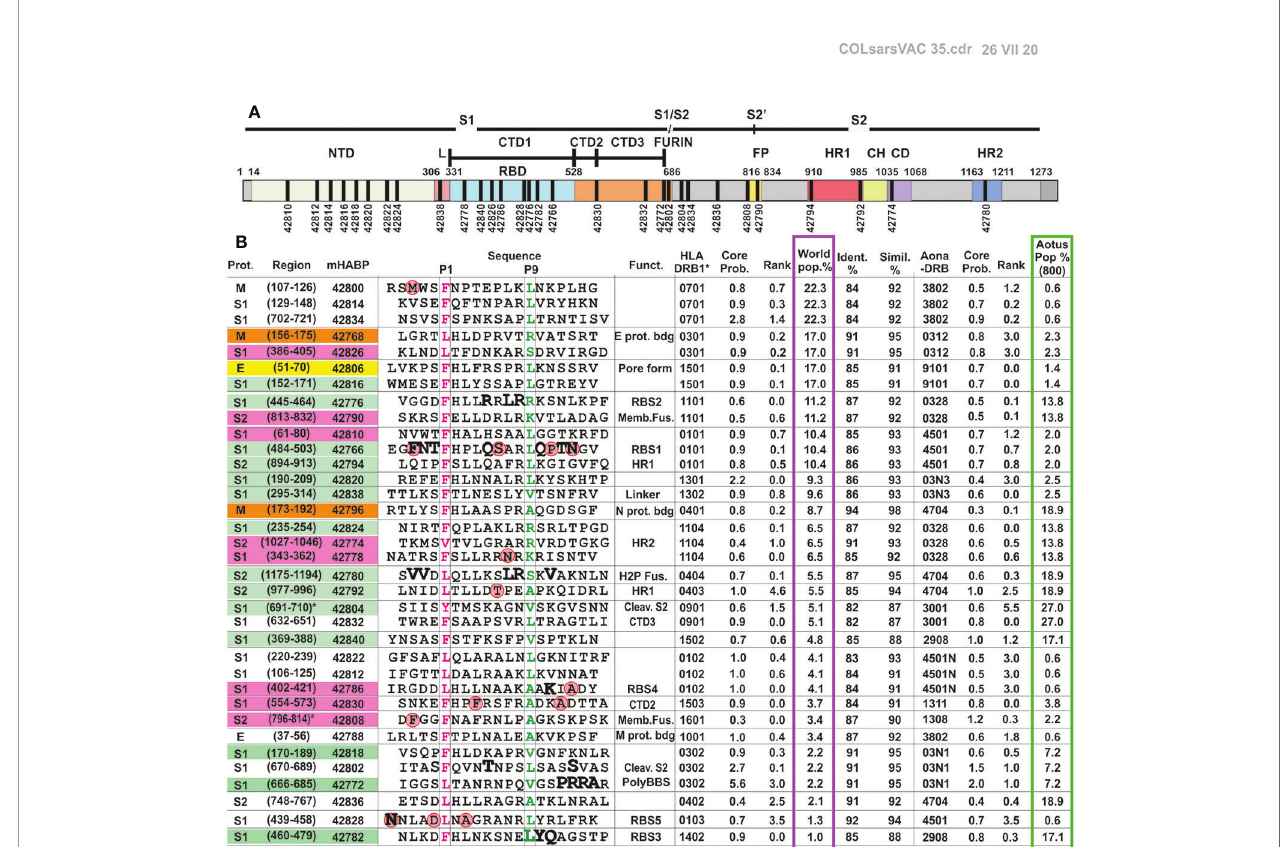
FIGURE 2 | Immunised peptide correlation in Aotus with HLA-DR b 1* molecules and their location in the SARS-CoV-2 S protein. (A) Schematic representation of SARS-CoV-2 S protein with the location of modi fi ed peptides in black fragment. (B) COLSARSPROT aa sequence for modi fi ed HLA-DR b 1* and Aona DR b peptide binding, grouped according to the most frequently occurring human allele. Prot.: original protein (S: spike, M: membrane, E: envelope); peptide Nr: Our institute ’ s serial peptide numbers for modi fi ed peptide synthesis; aa having genetic variation are shown inside red balls. LiViNAb-inducing peptides: S (green), M (orange) and E (yellow), promiscuous peptides (pink), those which did not induce Abs (colourless); Sequence: aa sequence with P1 (boxed, highlighted in pink) and P9 (green) for regions fi tting into HLA-DR b 1* PBR pockets. Biol. Funct.: biological function; HLA-DR b 1* allele, Core Prob.: core probability, rank, and frequency regarding the worldwide population (%). Ident.%: identity (%), Simil.(%): % similarity between HLA-DR b 1* and Aona-DR b alleles ’ core probability, rank, and frequency in the Aotus population (i.e. ~500+100 DNA-genotyped Aotus in this trial, i.e. ~1,200 alleles in